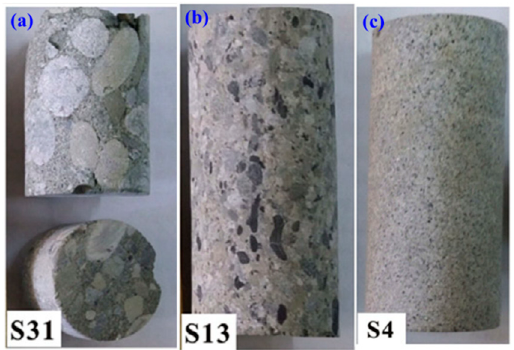
Figure 20. Glutenite cores with ( a ) coarse gravels, ( b ) medium gravels, and ( c ) fine gravels (Reproduced with permission from [51], Zhang et al., . Journal of Natural Gas Science and Engineering, Elsevier, 2015)